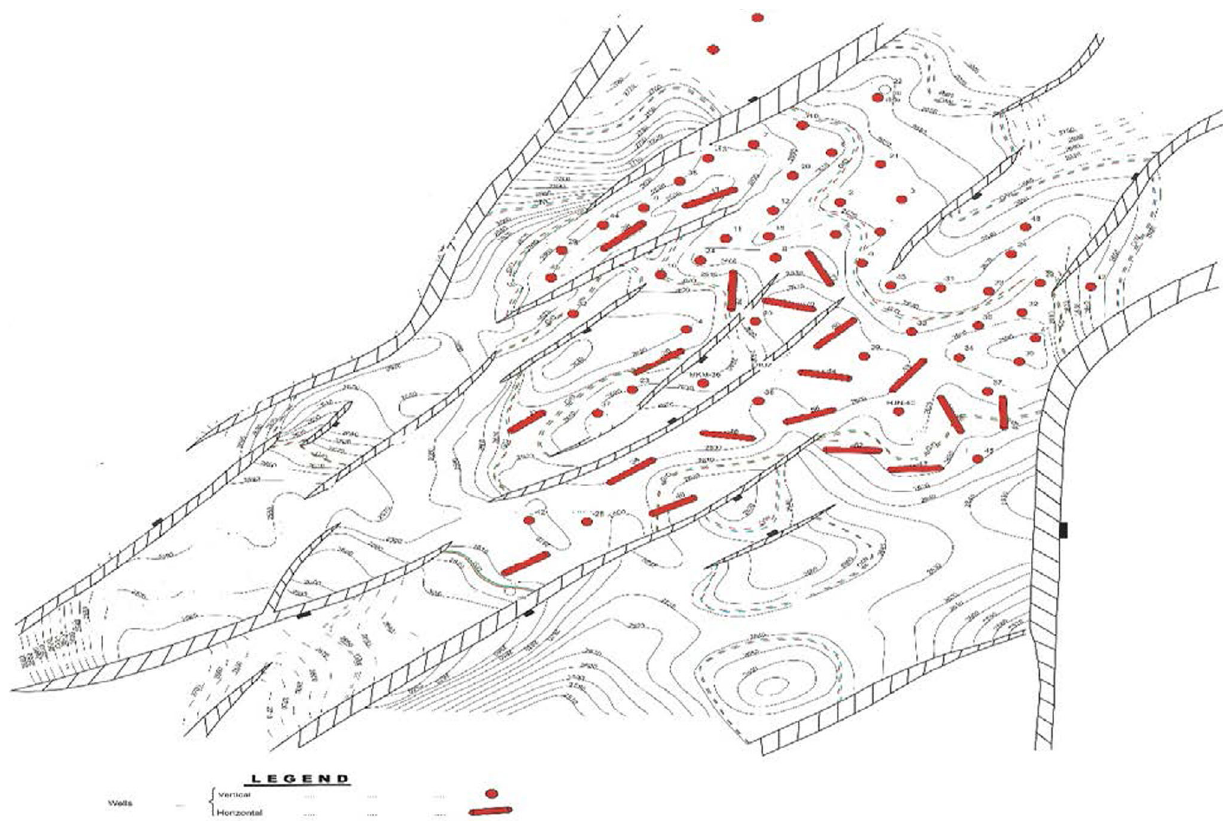
Fig. 1 Depth contour map on top of Oligocene